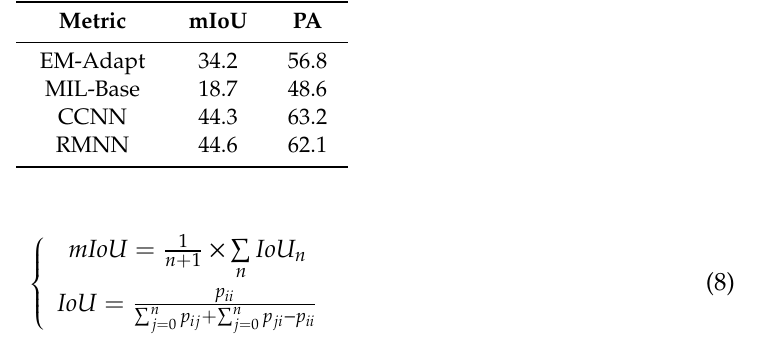
Table 3. We compare the fraction of pixel level semantically segmented mIoU and pixel accuracy (PA). Table 2. The mean intersection over union (mIoU) and pixel accuracy (PA) scores of the four methods. Metric